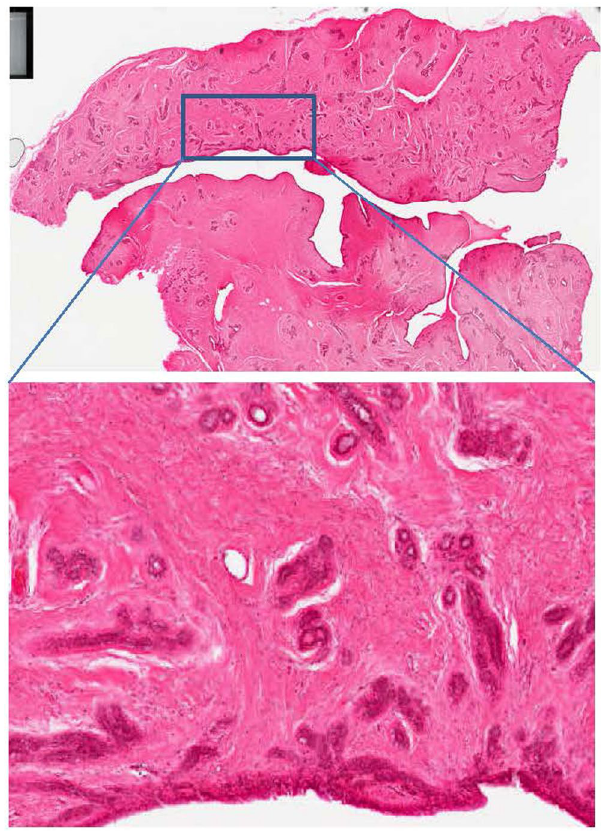
Figure 1. Image of an H&E stained fibroadenoma section described in the text. Bottom: enlargement of the area contained in the rectangle draw in the upper part of the figure (will be detailed in Fig. 2).